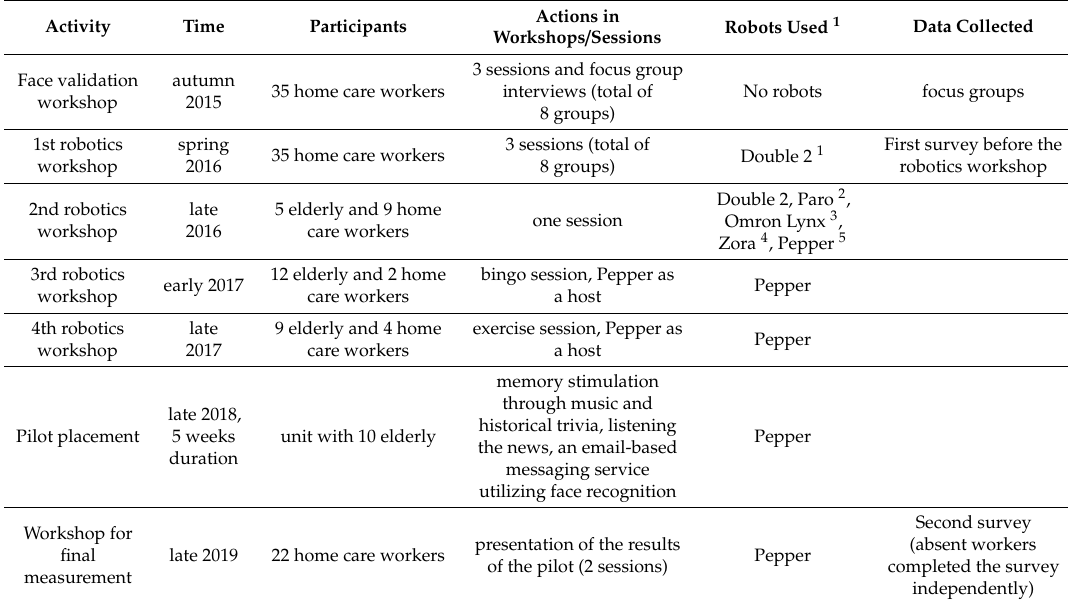
Table 1. Project